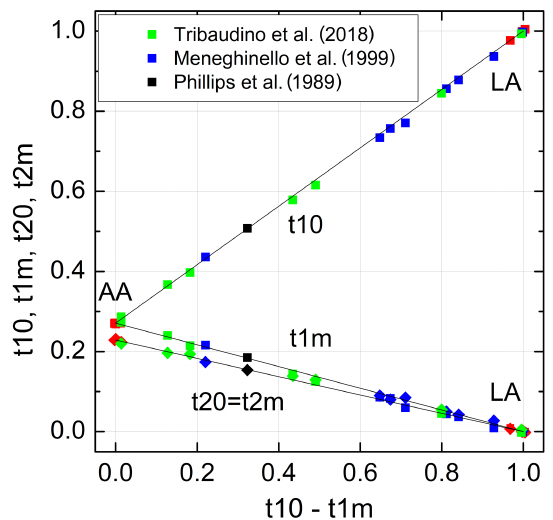
Figure 5. Al site occupancies t 1 0, t 1 m, t 2 0 = t 2 m (Eq. 9) vary lin- early with the difference (t 1 0 − t 1 m). The data are compiled in Ta- bles 1 and 3 (red: Wainwright and Starkey, 1968; Wenk and Kroll, 1984; Armbruster et al., 1990; Downs et al., 1994; Winter et al., 1970; Prewitt et al., 1976; Curetti et al., 2011; black: Phillips et al., 1989; green: Meneghinello et al., 1999; blue: Tribaudino et al., 2018). The sizes of the data points comply with the estimated